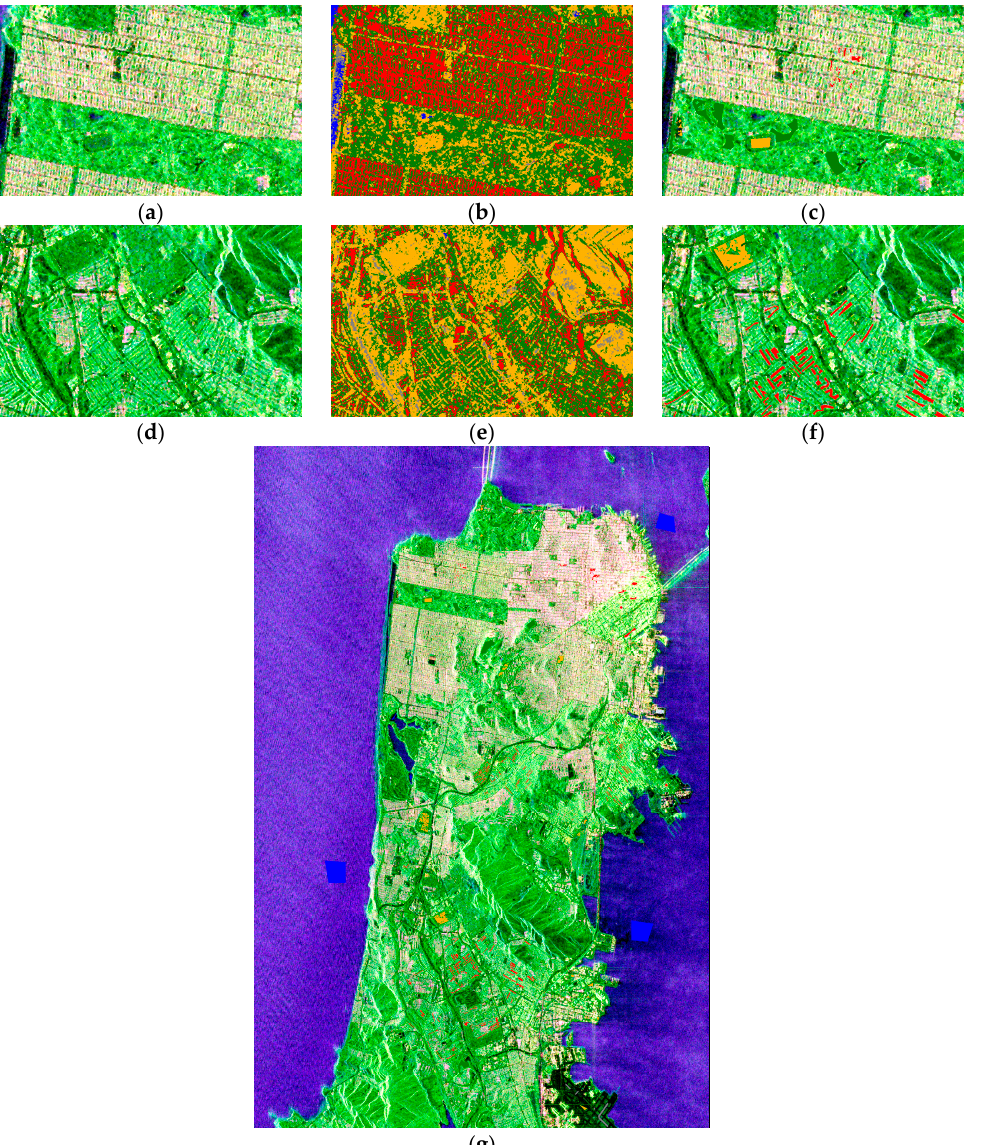
Figure 7. ( a ) The Pauli-basis image of Golden Gate Park; ( b ) pre-classification result; and ( c ) precise labeling; ( d ) The Pauli-basis image of the area in the red box from Figure 6a; ( e ) the corresponding pre-classification result; ( f ) the corresponding precise labeling; and ( g ) the precise labeling of the whole image.